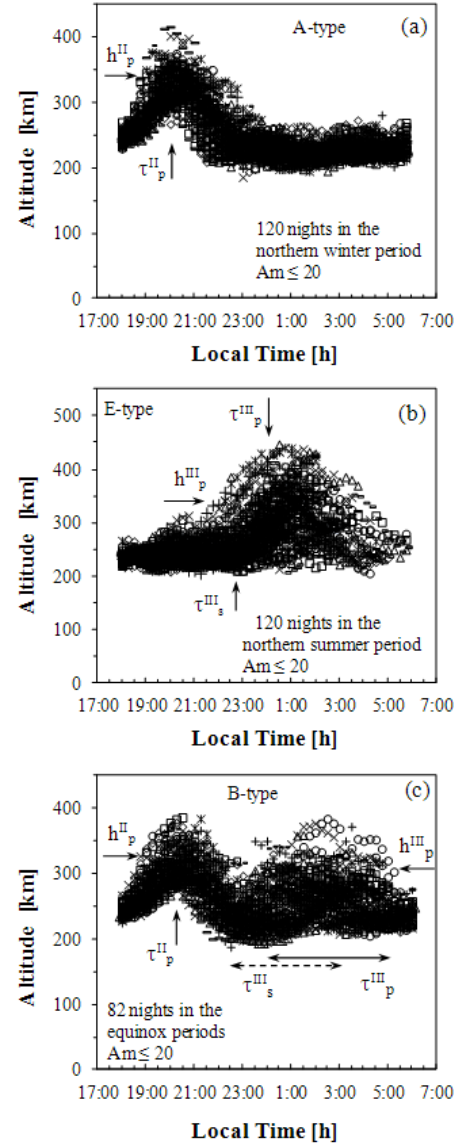
Figure 7. Night-to-night variability in the F-layer height as a func- tion of LT over the solar minimum 1995–1997. Samples of 120 nights were used (a) during the periods from November to March and (b) during the periods from May to mid-August; a sample of 82 nights was used in (c) during the periods from the last week of March to the end of April and from mid-August to mid-September. The plot exhibits (a) A-type patterns, (b) E-type patterns and (c) B-type patterns. In (a) and (c) , h II p and τ II p denote the altitude and the time at the peak of phase II, respectively; in (b) and (c) , h III p and τ III p denote the altitude and the time at the peak of phase III, respectively, and τ III s the time at the start. Note in (c) that τ III p and τ III s vary in extended